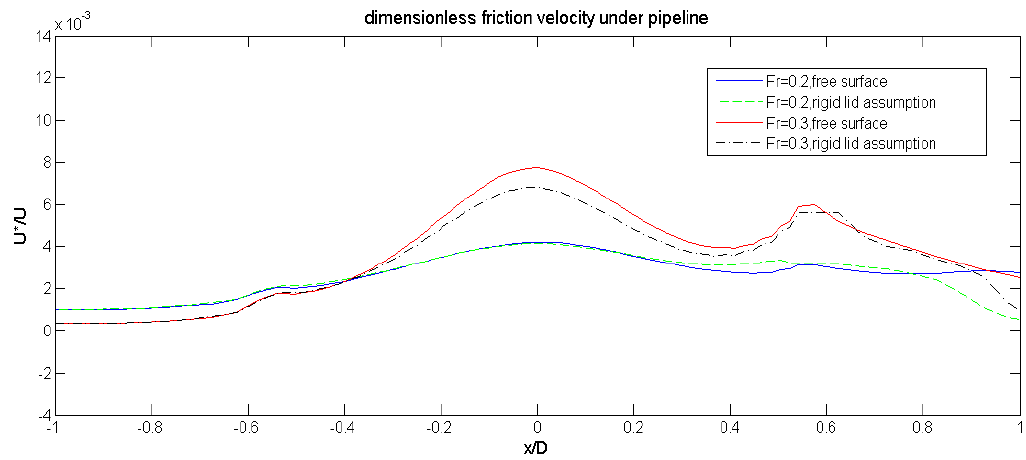
Figure 14. The distribution of dimensionless friction velocity under the pipeline at the initial moment.